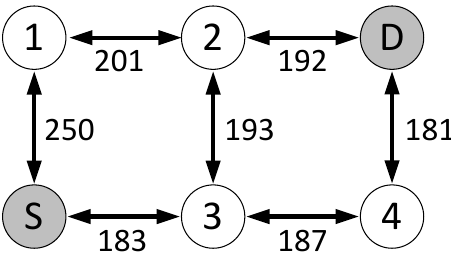
Figure 14. Example topology, where the Path-DR metric only finds one best route between the source (S) and destination (D) (S-1-2-D), while the ZigBee path cost metrics (HC, BeeStack and PLF) find three routes of equal cost (S-1-2-D, S-3-2-D, S-3-4-D). The numbers on the links represent the LQI values of the links. Note that all ZigBee path cost metrics will assign the same cost to all of the links shown in this example (see Figure